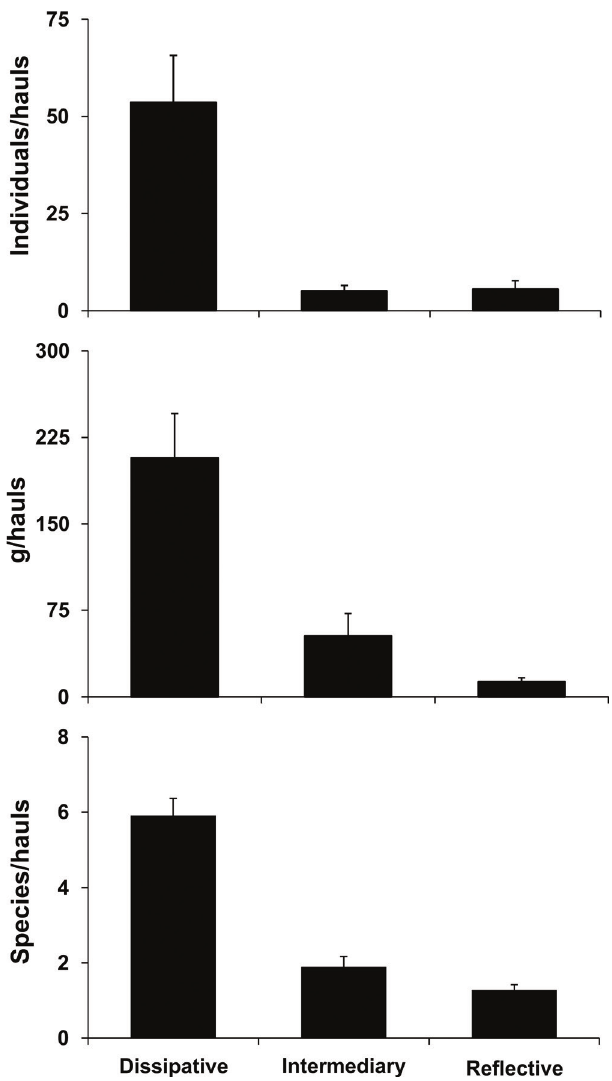
Fig. 3. Variation in the mean number of individuals (CPUE average ± SE), biomass ( ± SE) and number of species ( ± SE) at Mamanguape River estuary in